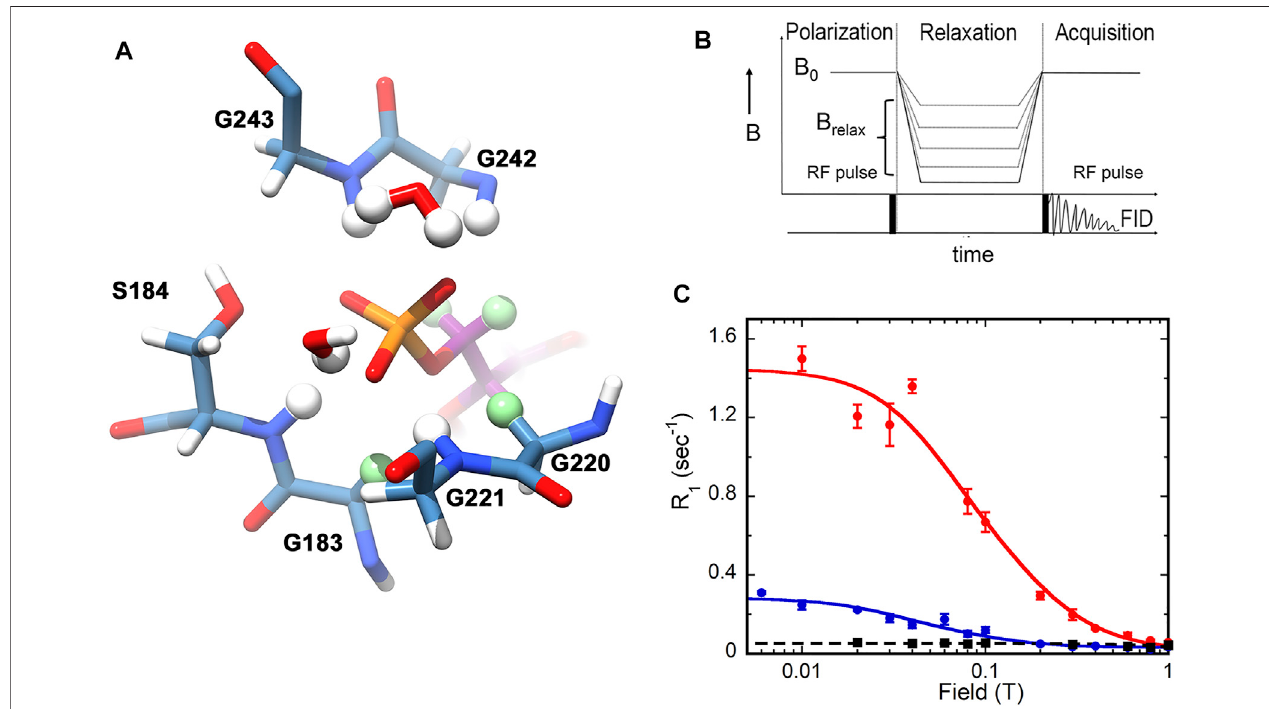
(cid:129) (cid:129) IMP NADP + complex of